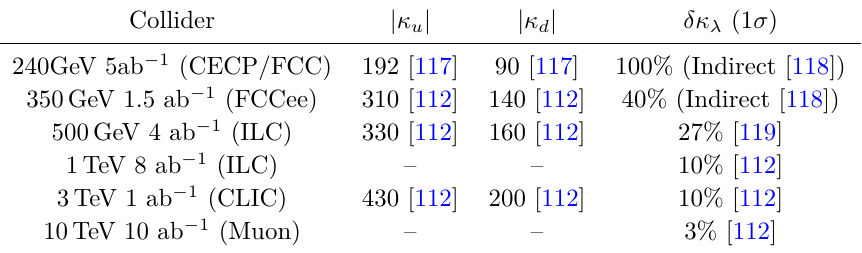
Table 6 . Prospective light-quark Yukawa and Higgs self-coupling sensitivities at future lepton colliders. The light-quark Yukawa bounds are 95% CL, while the self-coupling bounds are 1 σ or 68% CL sensitivity